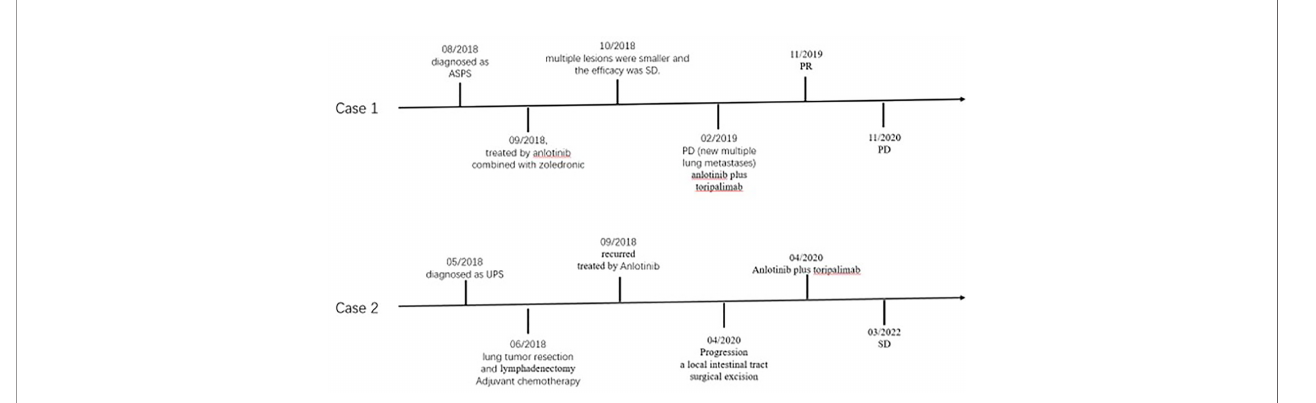
FIGURE 3 | Schematic picture showing the time line of treatment procedure.